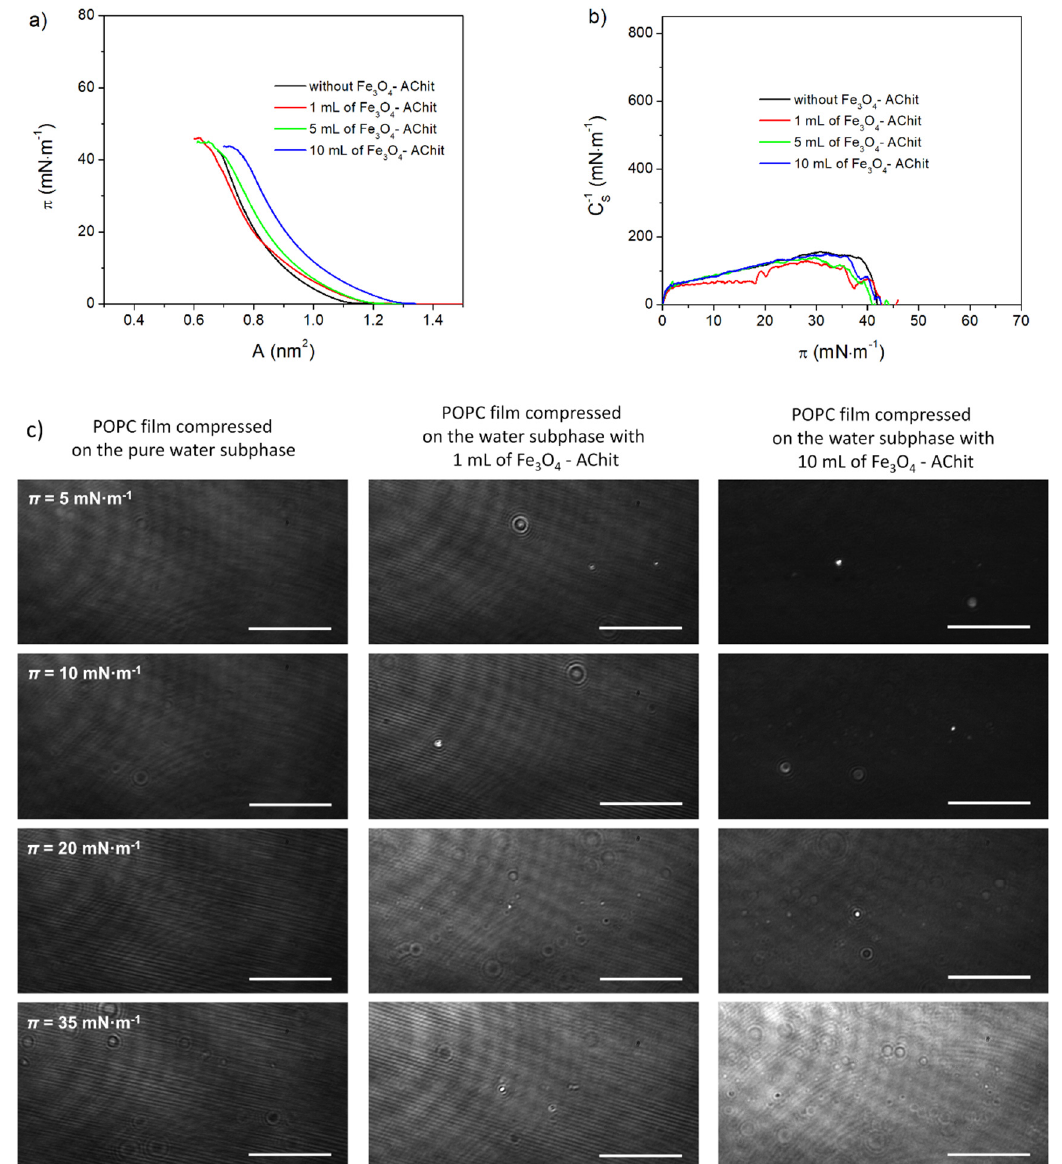
Figure 4. π -A isotherms ( a ), C S − 1 - π dependences ( b ), and BAM images ( c ) recorded during compression of the POPC monolayers on the water subphase with different concentrations of the Fe 3 O 4 -AChit nanoparticles. Length of scale bar in BAM images—100 µ